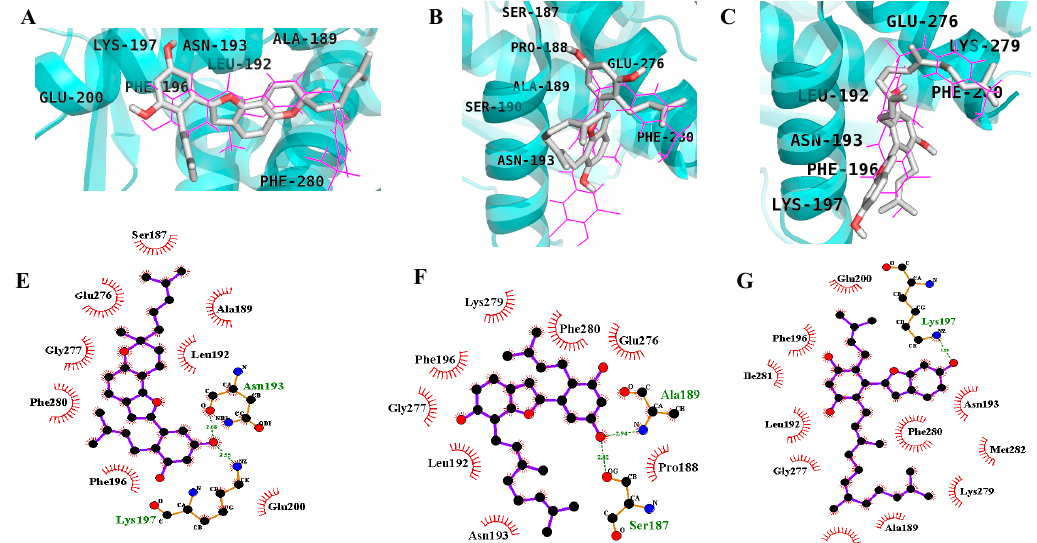
Figure 3. Binding mode for the PTP1B allosteric site with reported inhibitor compound A (pink line) by MD2 ( A ), MD ( B ), and MB ( C ). 2-D ligand interaction diagram of PTP1B allosteric inhibition by MD2 ( E ), MD ( F ), and MB ( G ). Dashed green lines indicate H-bonds. Carbon is in black, nitrogen is in blue, and oxygen is in red. Molecules 2019 , 24 , x